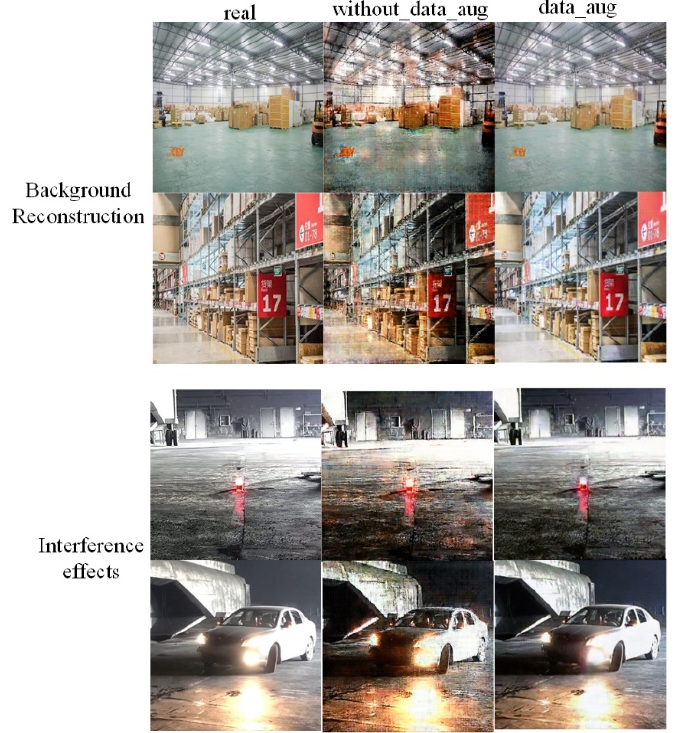
Figure 12. Comparison with before and after, using data augmentation.